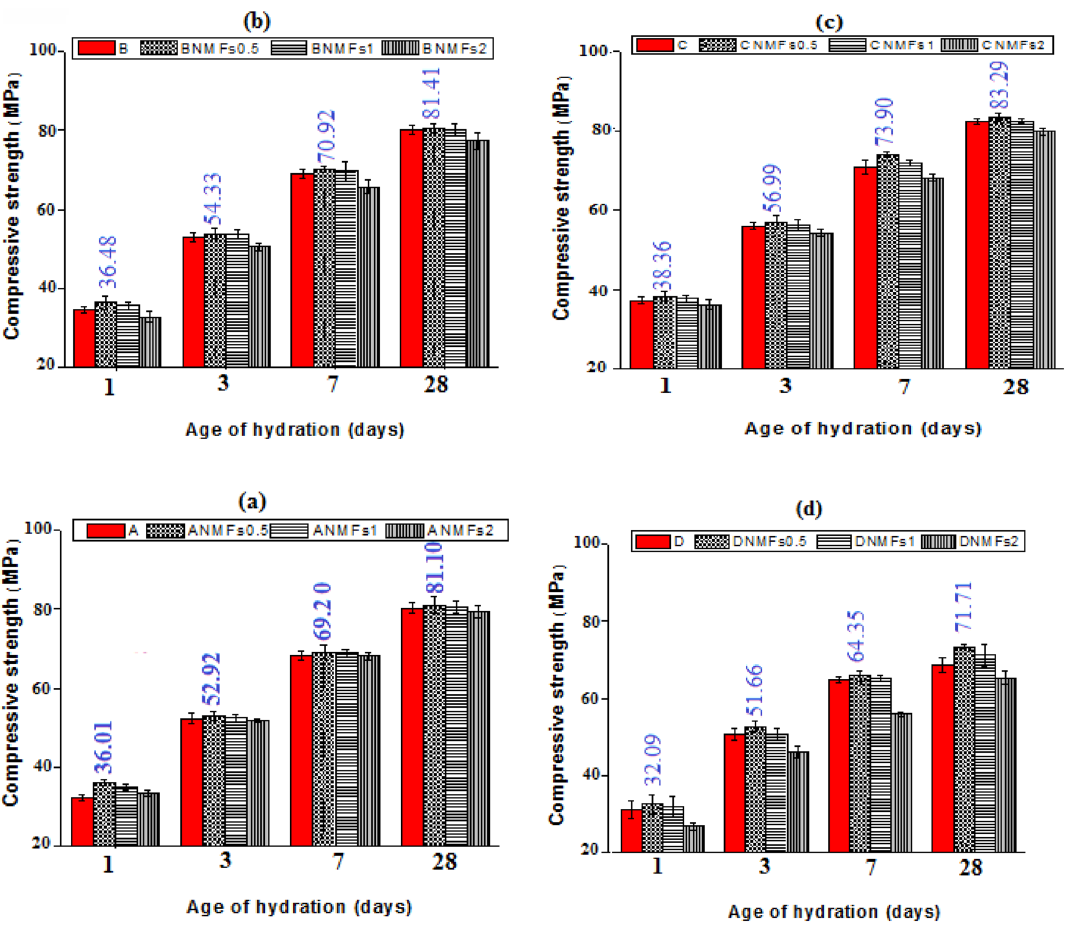
Figure 7. Compressive strength values of different hardened